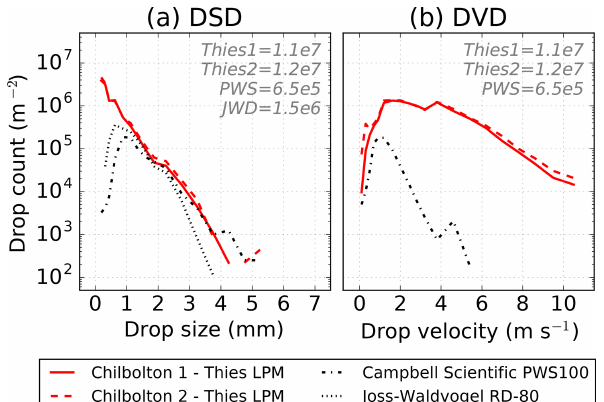
Figure 11. Drop characteristics of a heavy rain event at NFARR Atmospheric Observatory, Chilbolton, England, on 23 March 2017. Distributions are accumulated from 07:25 to 07:50UTC inclusively for a 26min summation. Panel (a) shows drop size distribution and panel (b) shows drop velocity distribution. The Joss-Waldvogel RD- 80 (JWD) does not provide drop velocity information. Each instru- ment has been normalized for sampling area and bin widths. Total drop count is listed in the top right of each plot. Both of the Thies LPMs have a higher total drop count, as well as significantly higher counts of small and high-velocity particles compared with the PWS and JWD. The frame of the Thies LPM may be splashing droplets into the beam, leading to increased counts of small, fast-moving